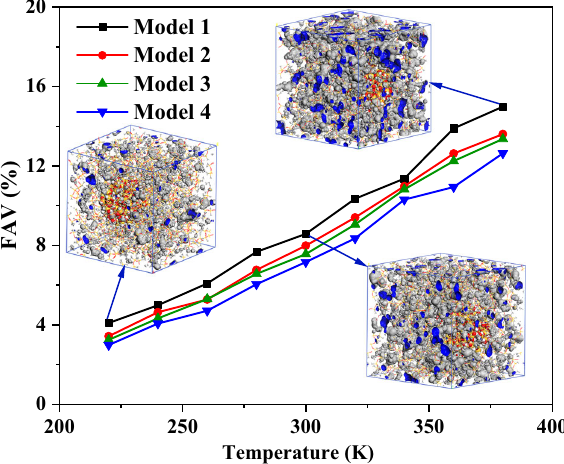
Fig. 5 The temperature dependence of FAVs for H 2 O molecules in the unaged and aged nano-silica/PDMS systems. The blue and gray regions in the insets represent the accessible volume and the occupied volume,